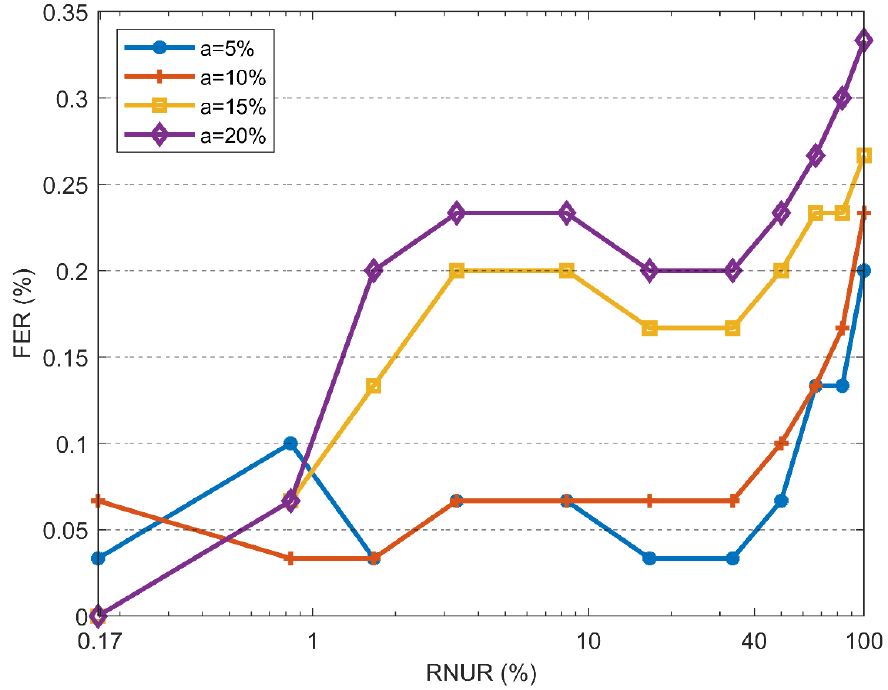
Figure 14. FER of the G3 PLC measured with different values of the RNUR and the modulation index of the RPPM modulated DC ‐ DC converter at 10 kHz switching frequency.